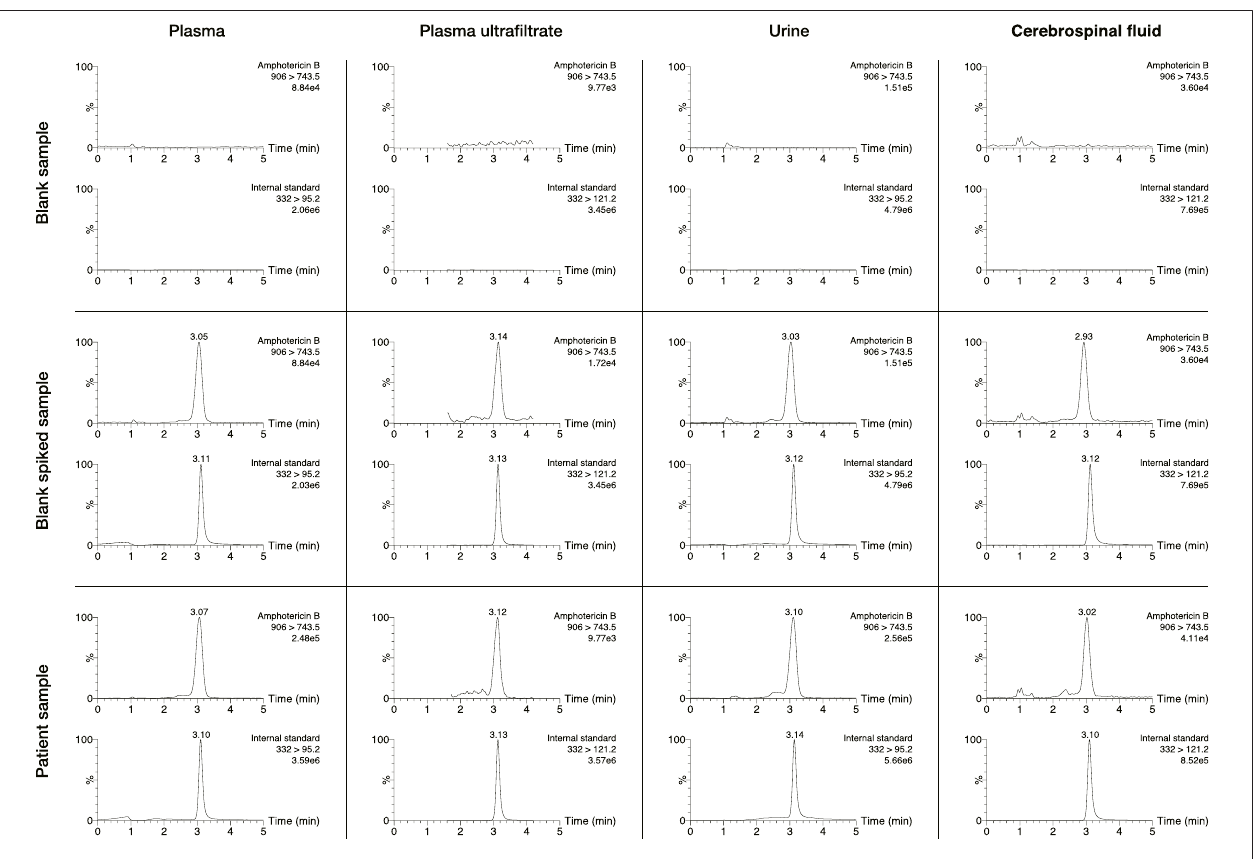
Frontiers in Chemistry |